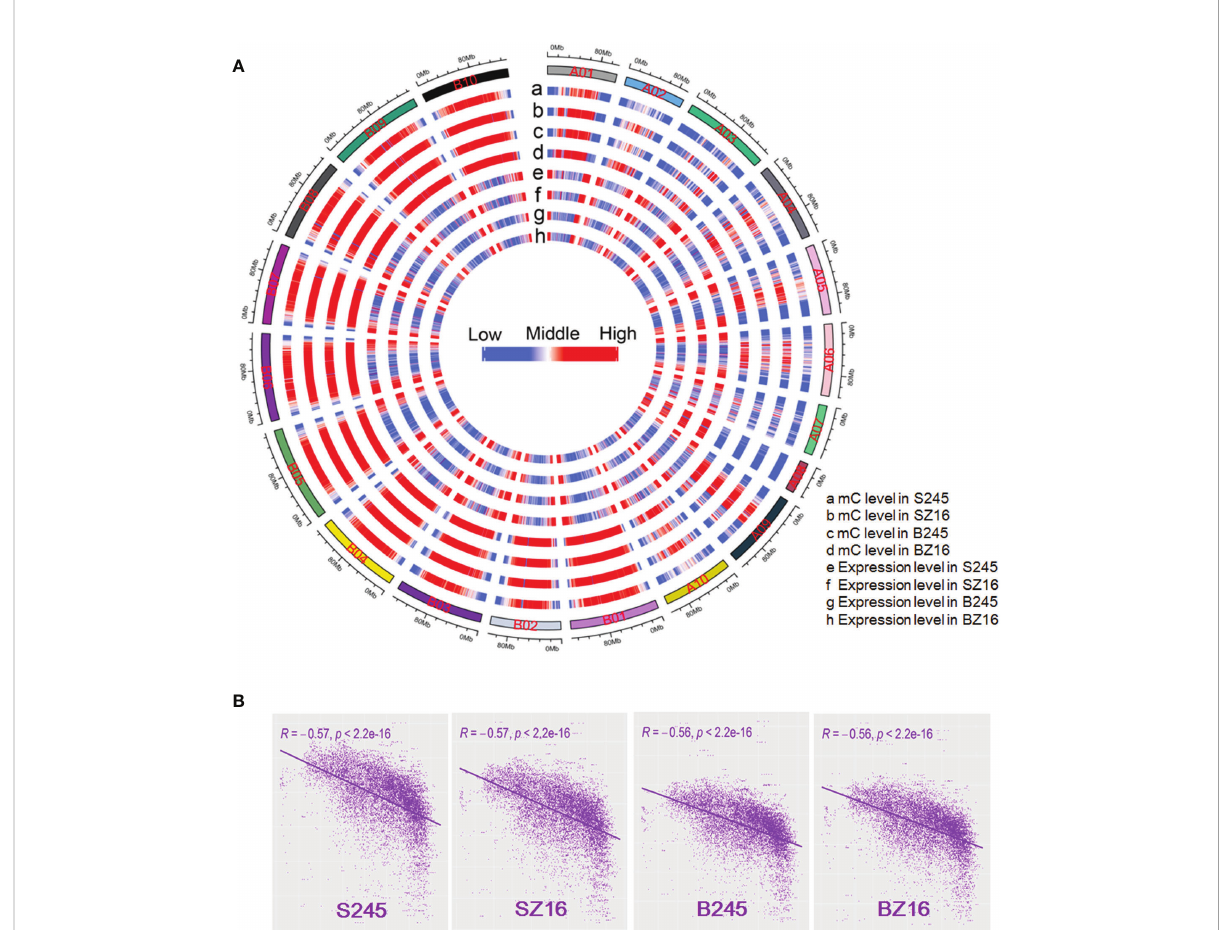
FIGURE 5 Genome-wide correlation between DNA methylation and gene expression. (A) A circle plot showed the overall DNA methylation level and gene expression level (log10 FPKM) in the reference chromosomes. FPKM fragments per kilobase of transcript per million mapped reads. mC indicated methylated cytosine. The data for each chromosome were analyzed in 1 Mb windows sliding 200 kb. (B) Analysis of correlation coef fi cient between DNA methylation and gene expression. S245 and SZ16 indicated seeds of 245 and Z16 at the R5 stage, respectively. B245 and BZ16 indicated seeds of 245 and Z16 at the R8 stage,